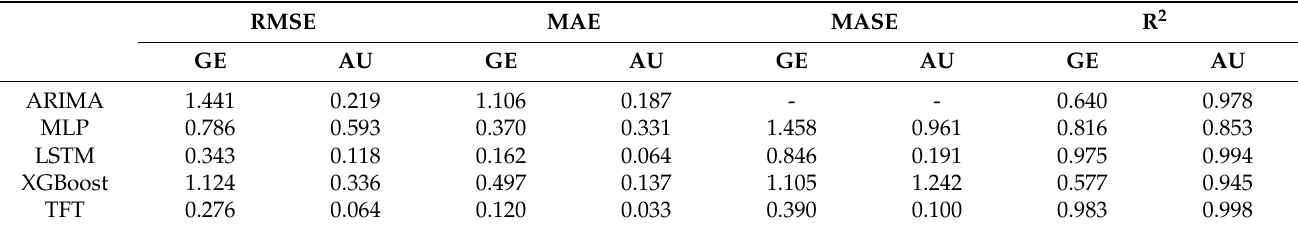
Table 7. Forecasting errors for the different models in both locations: Germany and Australia.